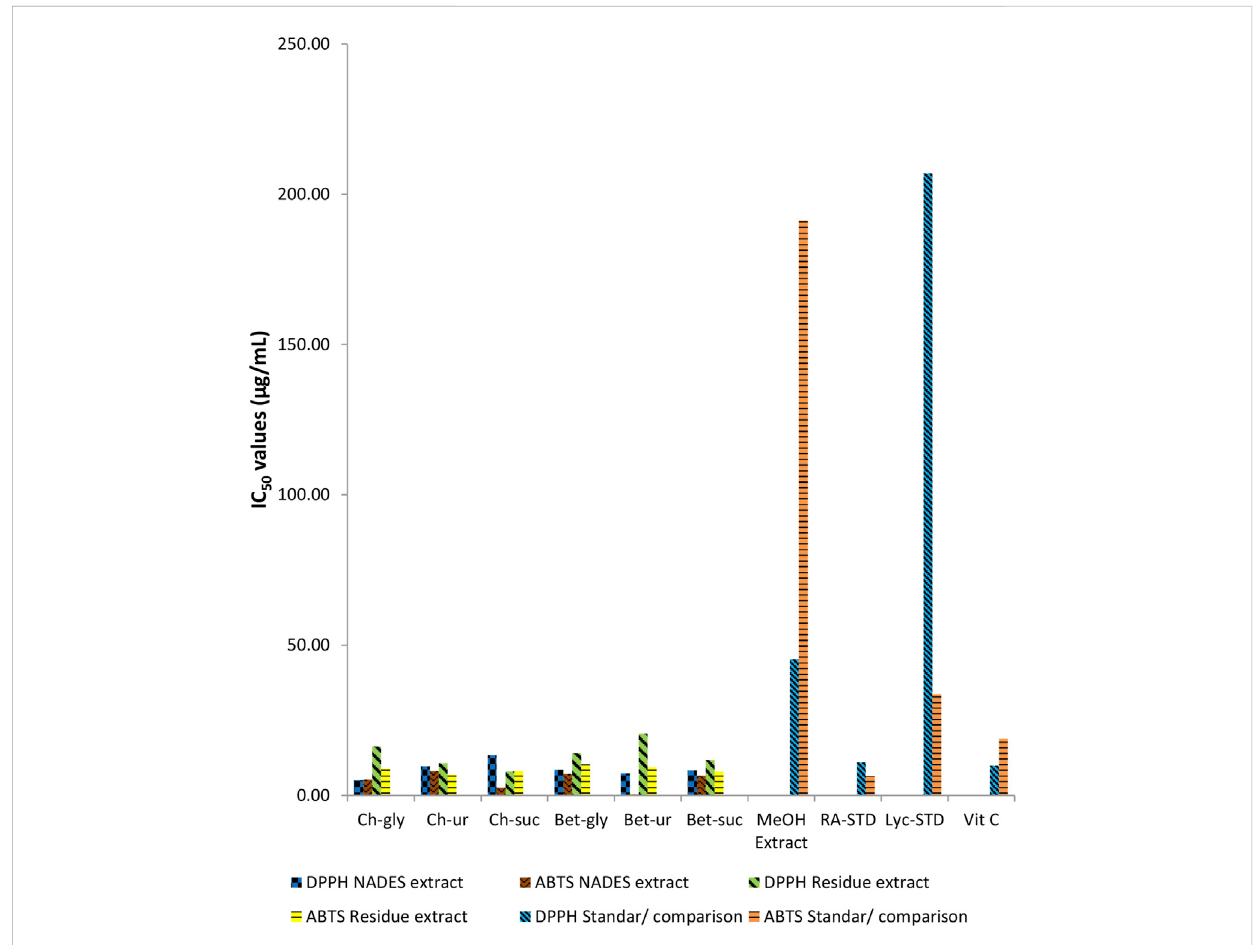
Comparison of antioxidant activities of comfrey leaf extracts by different NADES and methanol, and those of standard